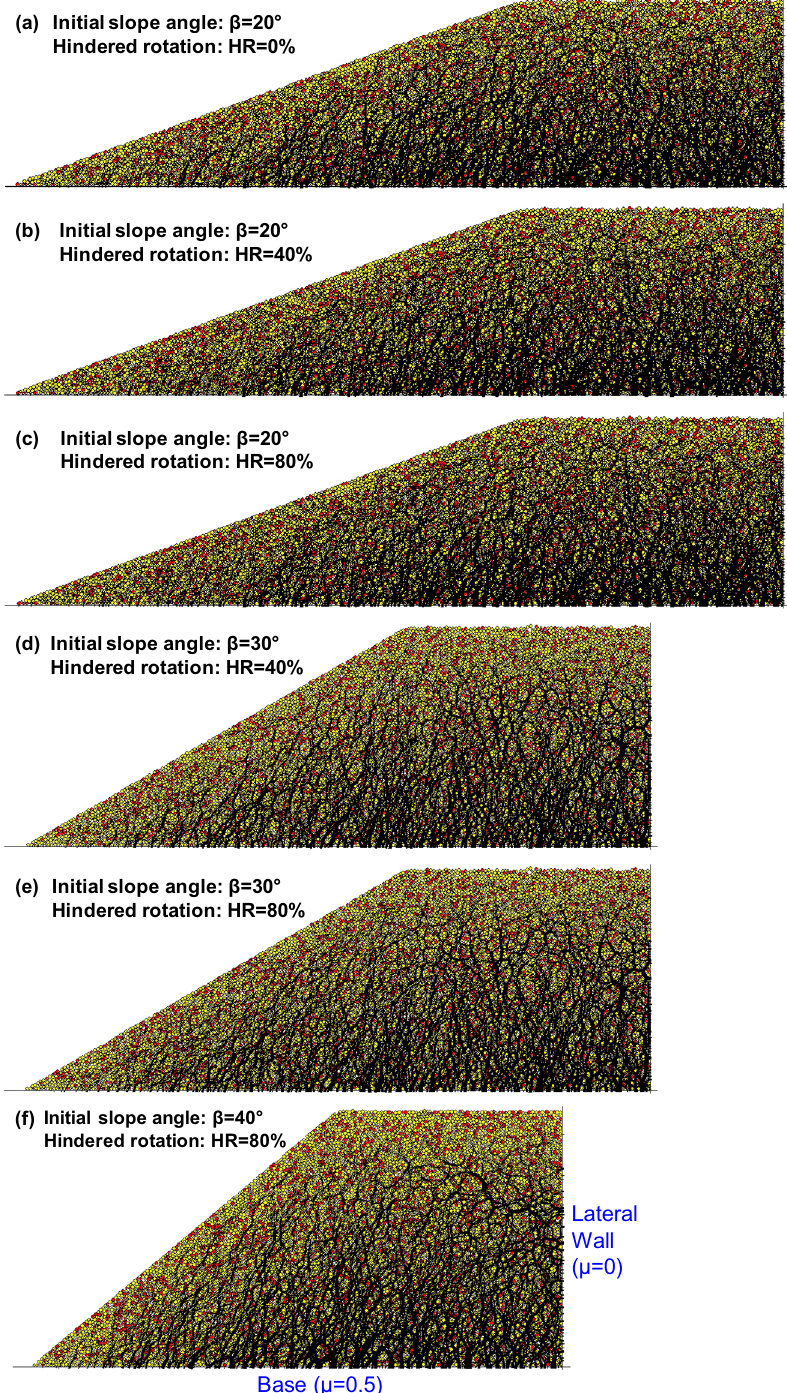
Figure 4. Specimen preparation and contact force chains before dissolution – All cases are shown at the same force scale. Soluble particles are shown in red (SF = 25%). Note the number of particles are the same for all simulations